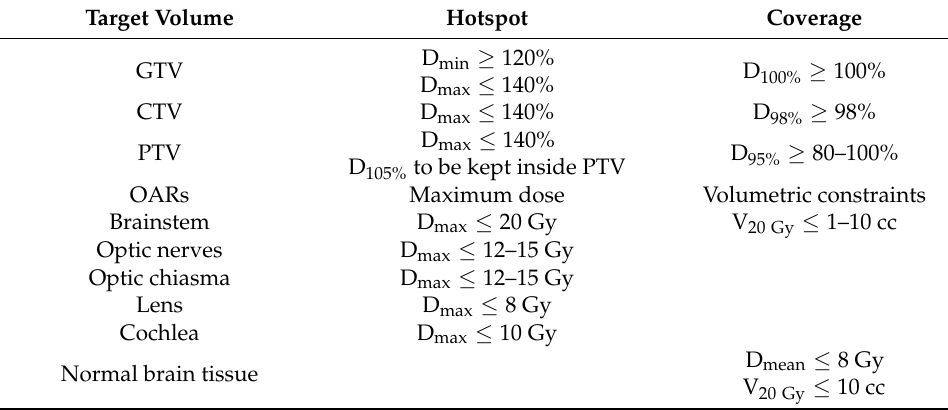
Table 3. Dose constraints for target volumes and organs at